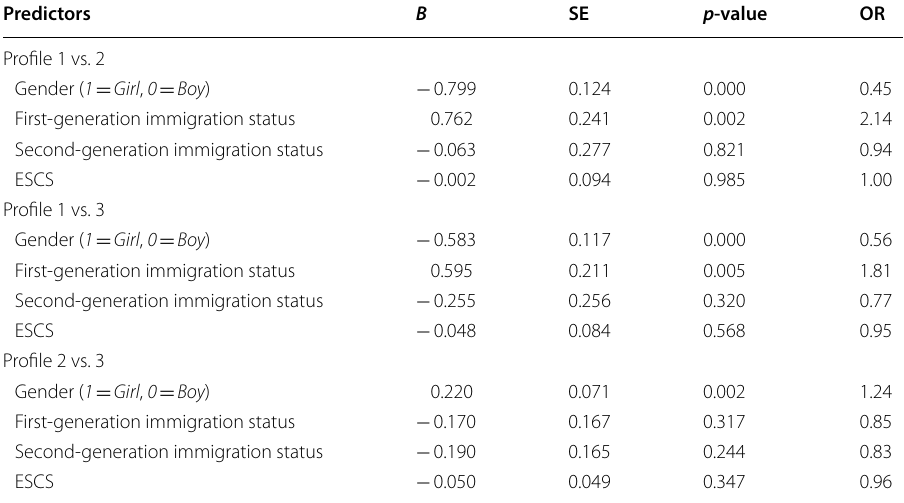
Table 6 Logistic regression coefficients explaining the probabilities of profile